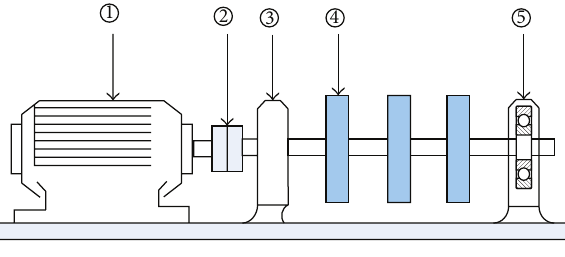
Figure 2: Test rig of fault bearing.